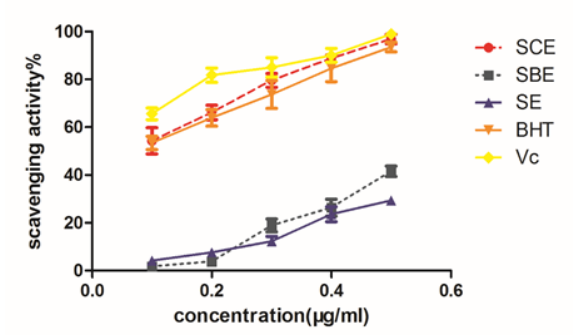
Figure 3: OH radical scavenging activities of CEOs, Vc and BHT at the concentrations of 0.1, 0.2, 0.3, 0.4 and 0.5 μg/mL. Each value is expressed as mean ± SEM.